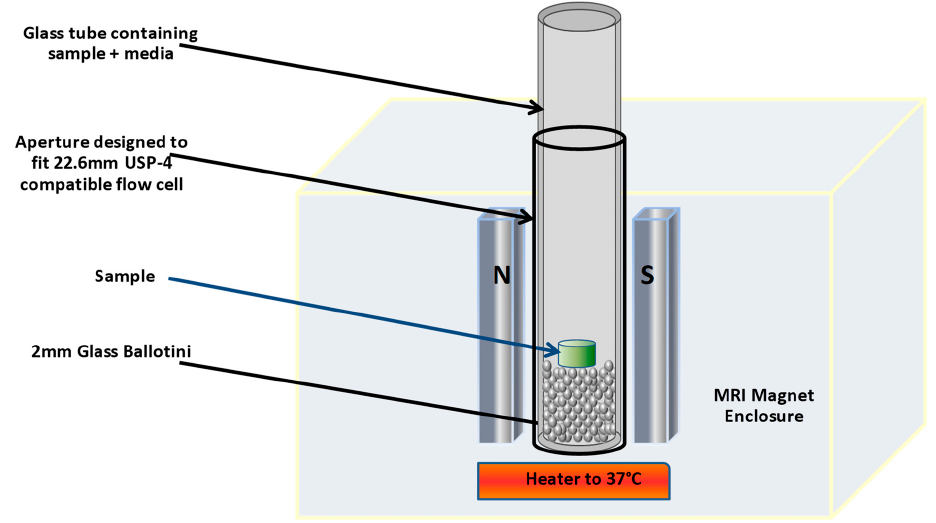
Figure 1. MARAN-i low-field magnetic resonance imager, with static cell set-up.